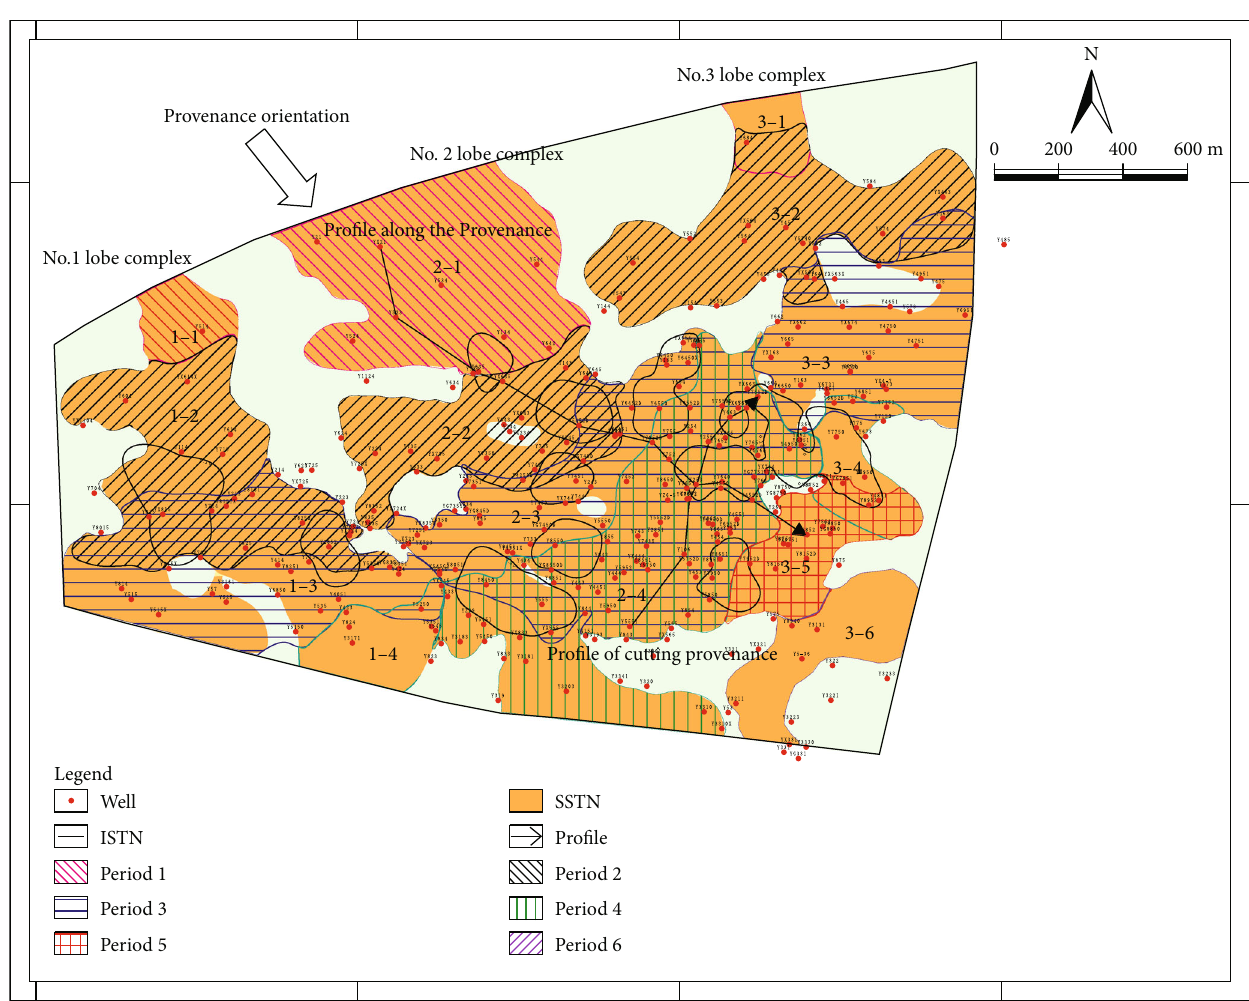
Figure 10: Pro fi le of single sand body in VII-15